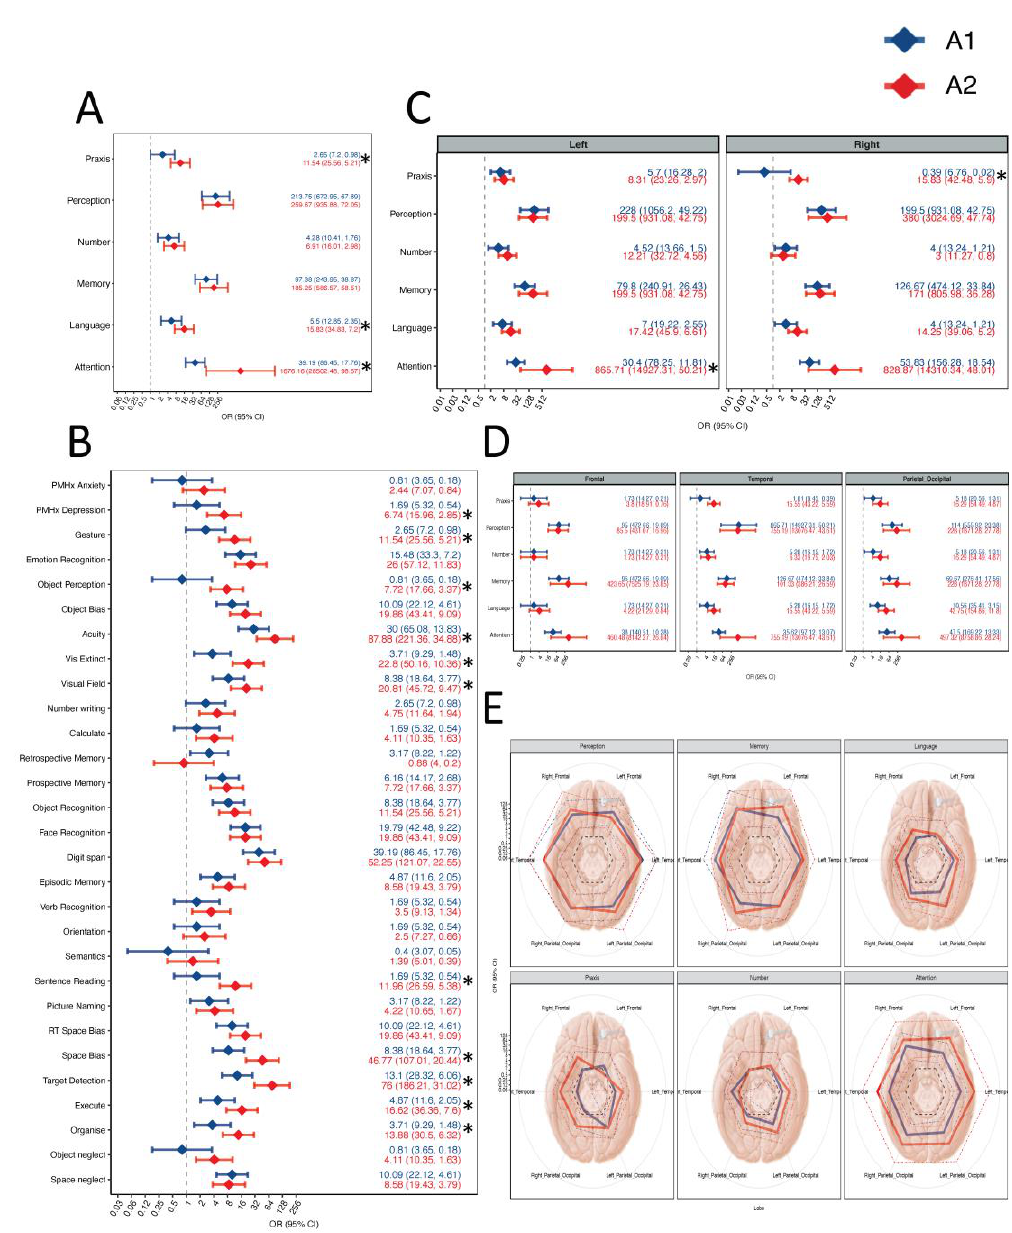
Figure 2. Risk of cognitive deficit at A1 and A2. ( A ) Forest plot displaying the OR of cognitive deficit at A1 and A2, relative to A0 (normative risk), for each cognitive domain across the entire cohort. ( B ) Forest plot displaying the OR of cognitive deficit at A1 and A2, healthy control risk (dotted line) for each cognitive test across the entire cohort. ( C ) Forest plot displaying the OR of cognitive deficit at A1 and A2, healthy control risk (dotted line) for each cognitive domain, stratified by hemispheric location of the lesion. ( D ) Forest plot displaying the OR of cognitive deficit at A1 and A2, healthy control risk (dotted line), for each cognitive domain, stratified by lobar location of the lesion. ( E ) Radar plot displaying the OR of cognitive deficit at A1 and A2, healthy control risk (dotted line), for each cognitive domain, stratified by location (hemisphere and lobe) of the lesion. Data are shown as OR (diamonds) ± 95% CI. OR > 1 indicates an association with increased risk of cognitive deficit relative to baseline, while OR < 1 indicates an association with reduced risk of cognitive deficit relative to baseline. Statistically significant differences between the risk of cognitive deficit at A1 and at A2 are marked by a ‘*’. Raw data are available as scatterplots in Supplementary